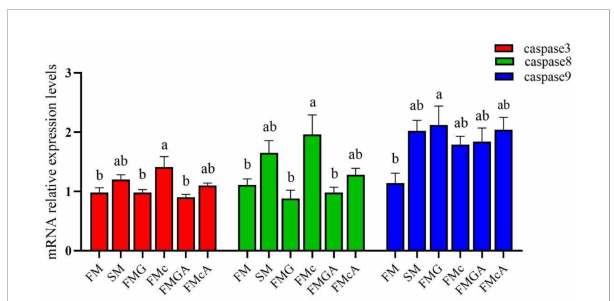
FIGURE 5 Relative expression levels of apoptosis factors in the intestine of mirror carp at different treatments fed with diets containing fi shmeal (FM), soybean meal (SM), glycinin (FMG), B-conglycinin (FMc), AKG+ glycinin (FMGA), AKG+B-conglycinin (FMcA) after eight weeks. Data are presented as means + SE, (n = 3). a, b, c Mean values with different letters were signi fi cantly different (P<0.05).